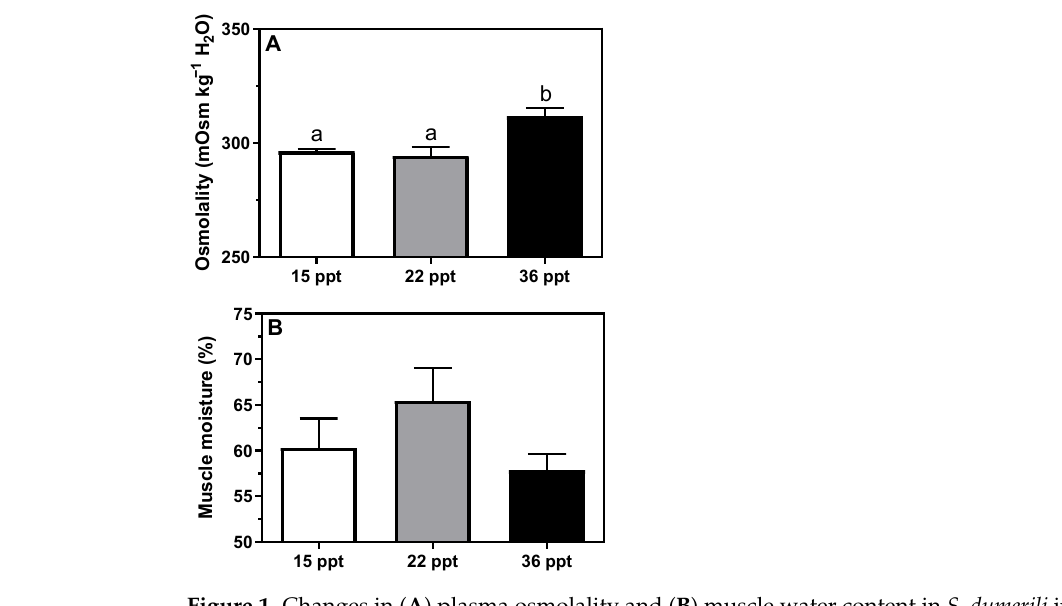
Table 2. Plasma and hepatic parameters in S. dumerili individuals acclimated to different environmen- tal salinities (15, 22, and 36 psu). Data are presented as mean ± SEM (n = 8–12). Values are expressed as grams of the wet weight of tissue (g − 1 w.w.). Different superscript letters indicate significant differences among salinities ( p < 0.05, one-way ANOVA).